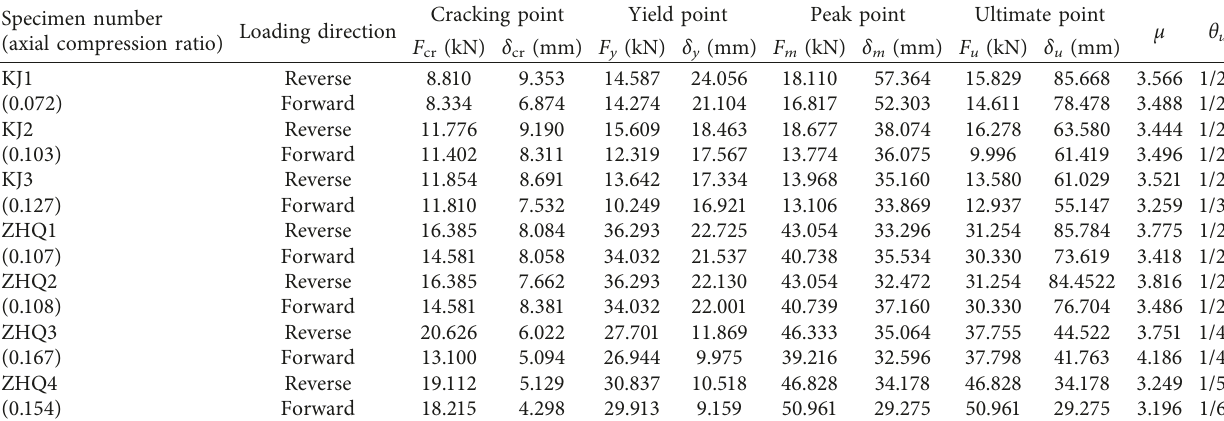
Table 5: Test results of characteristic points. Specimen number Loading (axial compression ratio)